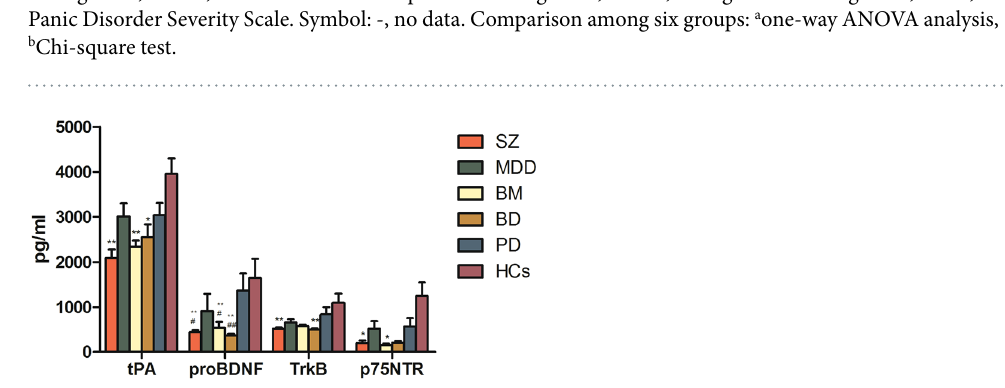
Figure 1. Serum concentrations of four proteins in patients with different disorders and HCs. Abbreviations: SZ, schizophrenia paranoid type; MDD, major depressive disorder; BM, bipolar mania; BD, bipolar depression; PD, panic disorder; HCs, healthy controls; tPA, tissue plasminogen activator; proBDNF, precursor brain- derived neurotrophic factor; TrkB, tropomyosin-related kinase B; p75NTR, neurotrophin receptor p75. Compared with HCs group by Kruskal-Wallis test followed by Dunnett T3 test, * P < 0.05, ** P < 0.01. Compared with PD group by Kruskal-Wallis test followed by Dunnett T3 test, # P < 0.05, ## P < 0.01. Several extreme values which below the minimum detectable concentration of the kit or higher than three standard deviations were removed out from tPA, proBDNF, TrkB and p75NTR. After removing out the extreme values, the remaining number of cases showed as follows: tPA (33 SZ, 30 MDD, 29 BM, 22 BD, 30 PD and 30HCs), proBDNF (32 SZ, 28 MDD, 29 BM, 21 BD, 28 PD and 28 HCs), TrkB (33 SZ, 29 MDD, 29 BM, 21 BD, 29 PD and 29 HCs), p75NTR (27 SZ, 26 MDD, 23 BM, 19 BD, 25 PD and 27 HCs). Finally, 27 SZ, 25 MDD, 22 BM, 19 BD, 24 PD patients and 25 HCs had all the four